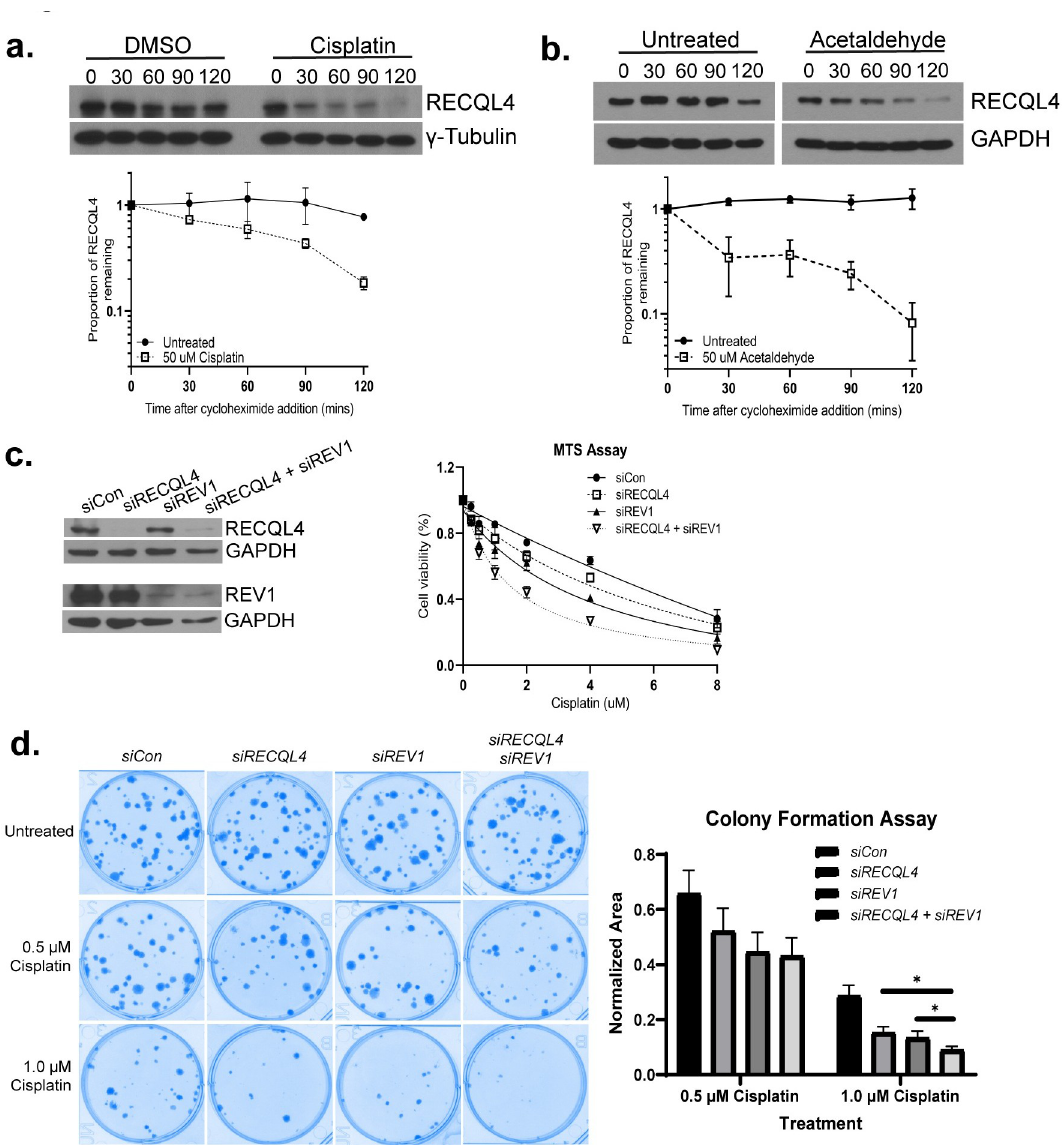
Fig 5. RECQL4 functions in a separate pathway from REV1 and is degraded following DNA crosslinks. (A) RECQL4 levels decrease following cisplatin treatment. U2OS cells were incubated with 50 μ g/ml cycloheximide in the presence or absence of 50 μ g/ ml cisplatin. Protein extracts were analyzed by western blot for endogenous RECQL4 protein levels ( α -RECQL4) or a loading control, Tubulin ( γ -Tubulin), at the indicated time points. Quantification of the proportion of RECQL4 remaining relative to time 0 (before CHX addition) and the loading control, Tubulin, are plotted on the graph in log scale. Each experiment was performed in triplicate with standard error plotted (Raw densitometry data in Sheets A-C in S6 Data ). (B) RECQL4 protein levels decrease following acetaldehyde treatment. U2OS cells were incubated with 50 μ g/ml cycloheximide in the presence or absence of 50 μ g/ml acetaldehyde. Protein extracts were analyzed by western blot for endogenous RECQL4 protein levels ( α -RECQL4) or a loading control, GAPDH ( α - GAPDH), at the indicated time points. Quantification of the proportion of RECQL4 remaining relative to time 0 (before CHX addition) and the loading control, GAPDH, are plotted on the graph in log scale. Each experiment was performed in triplicate with standard error plotted (Raw densitometry data in Sheets D-F in S6 Data ). (C) Cisplatin exposed U2OS cells exhibit decreased viability when both RECQL4 and REV1 are knocked down by siRNA. MTS assay was performed on after 72 hr exposure to the indicated dose of cisplatin. Western is shown to confirmed knockdown of proteins, note since RECQL4 and REV1 are of similar size, the same samples were loaded twice to detect RECQL4 and REV1. Each experiment was performed three times with mean and standard errors plotted (Unprocessed data in S7 Data ). (D) Decreased cell viability following cisplatin exposure when both RECQL4 and REV1 are knocked down. Clonogenic survival assay with siControl (scrambled siCon), siRECQL4, siREV1, and siRECQL4 siREV1 treated cells with or without cisplatin. Each condition was plated in triplicate for each experiment and the experiment was performed three times with mean and standard errors plotted (Colony quantification in S8 Data ).